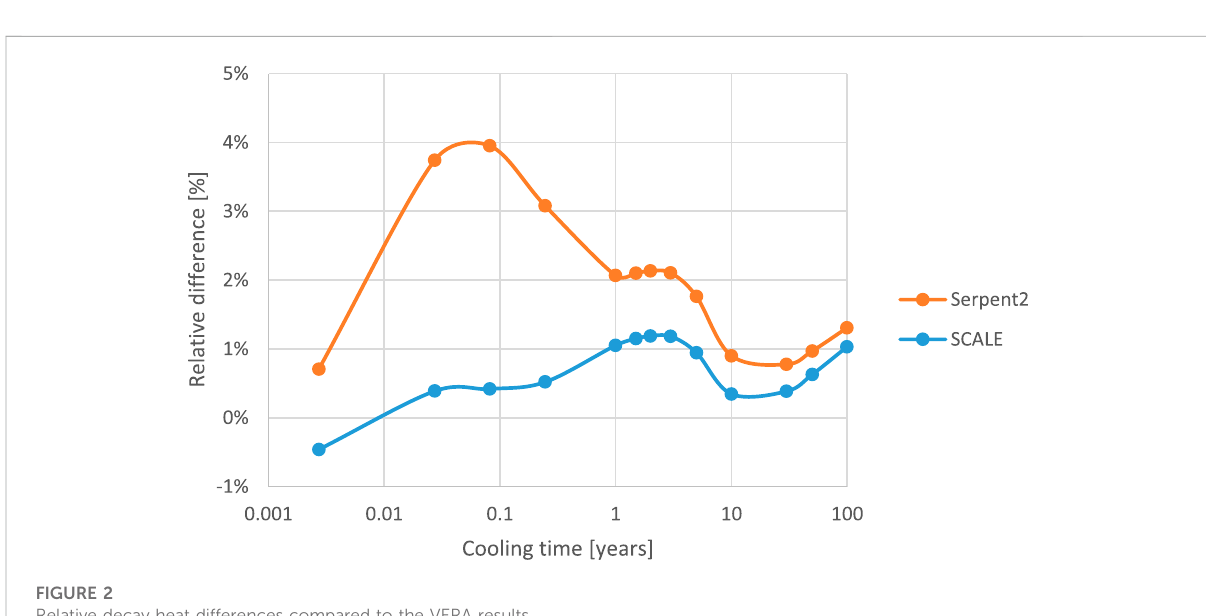
Relative decay heat differences compared to the VERA